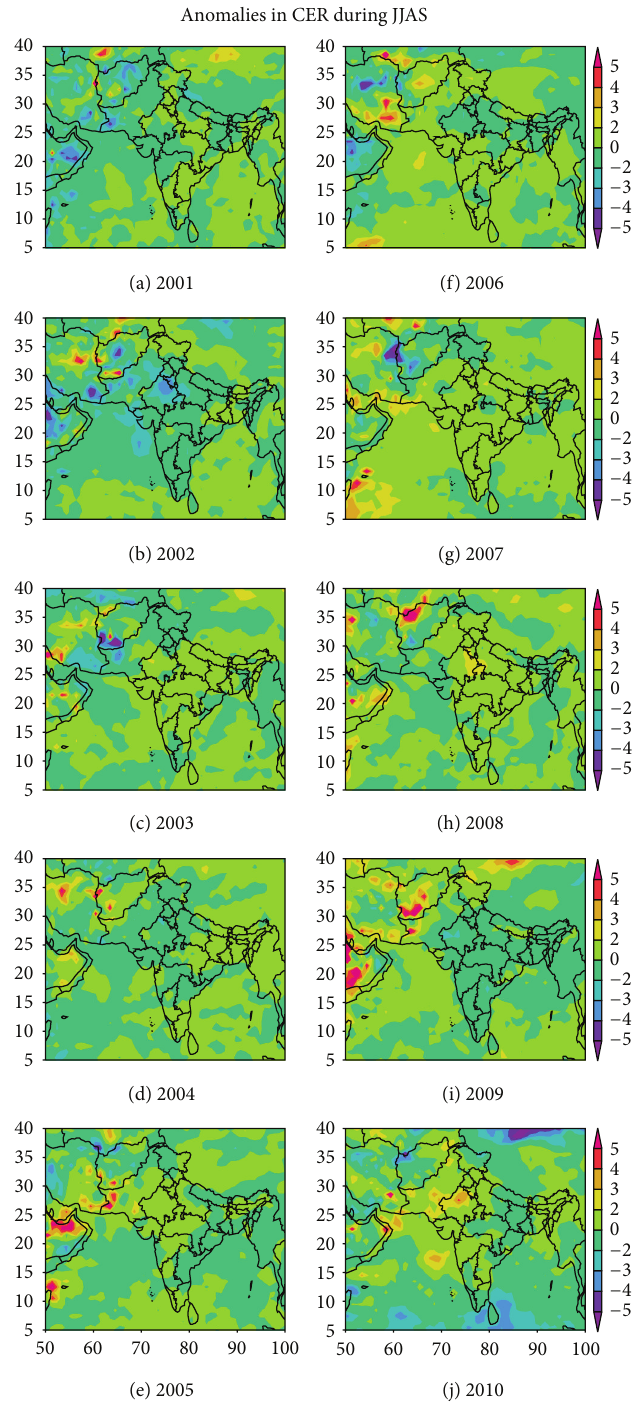
Figure 12: Anomalies in cloud effective radius (CER, 𝜇 m) during the southwest monsoon season (JJAS) in (a) 2001, (b) 2002, (c) 2003, (d) 2004, (e) 2005, (f) 2006, (g) 2007, (h) 2008, (i) 2009, and (j) 2010 over the Arabian Sea, India, and the Bay of Bengal.